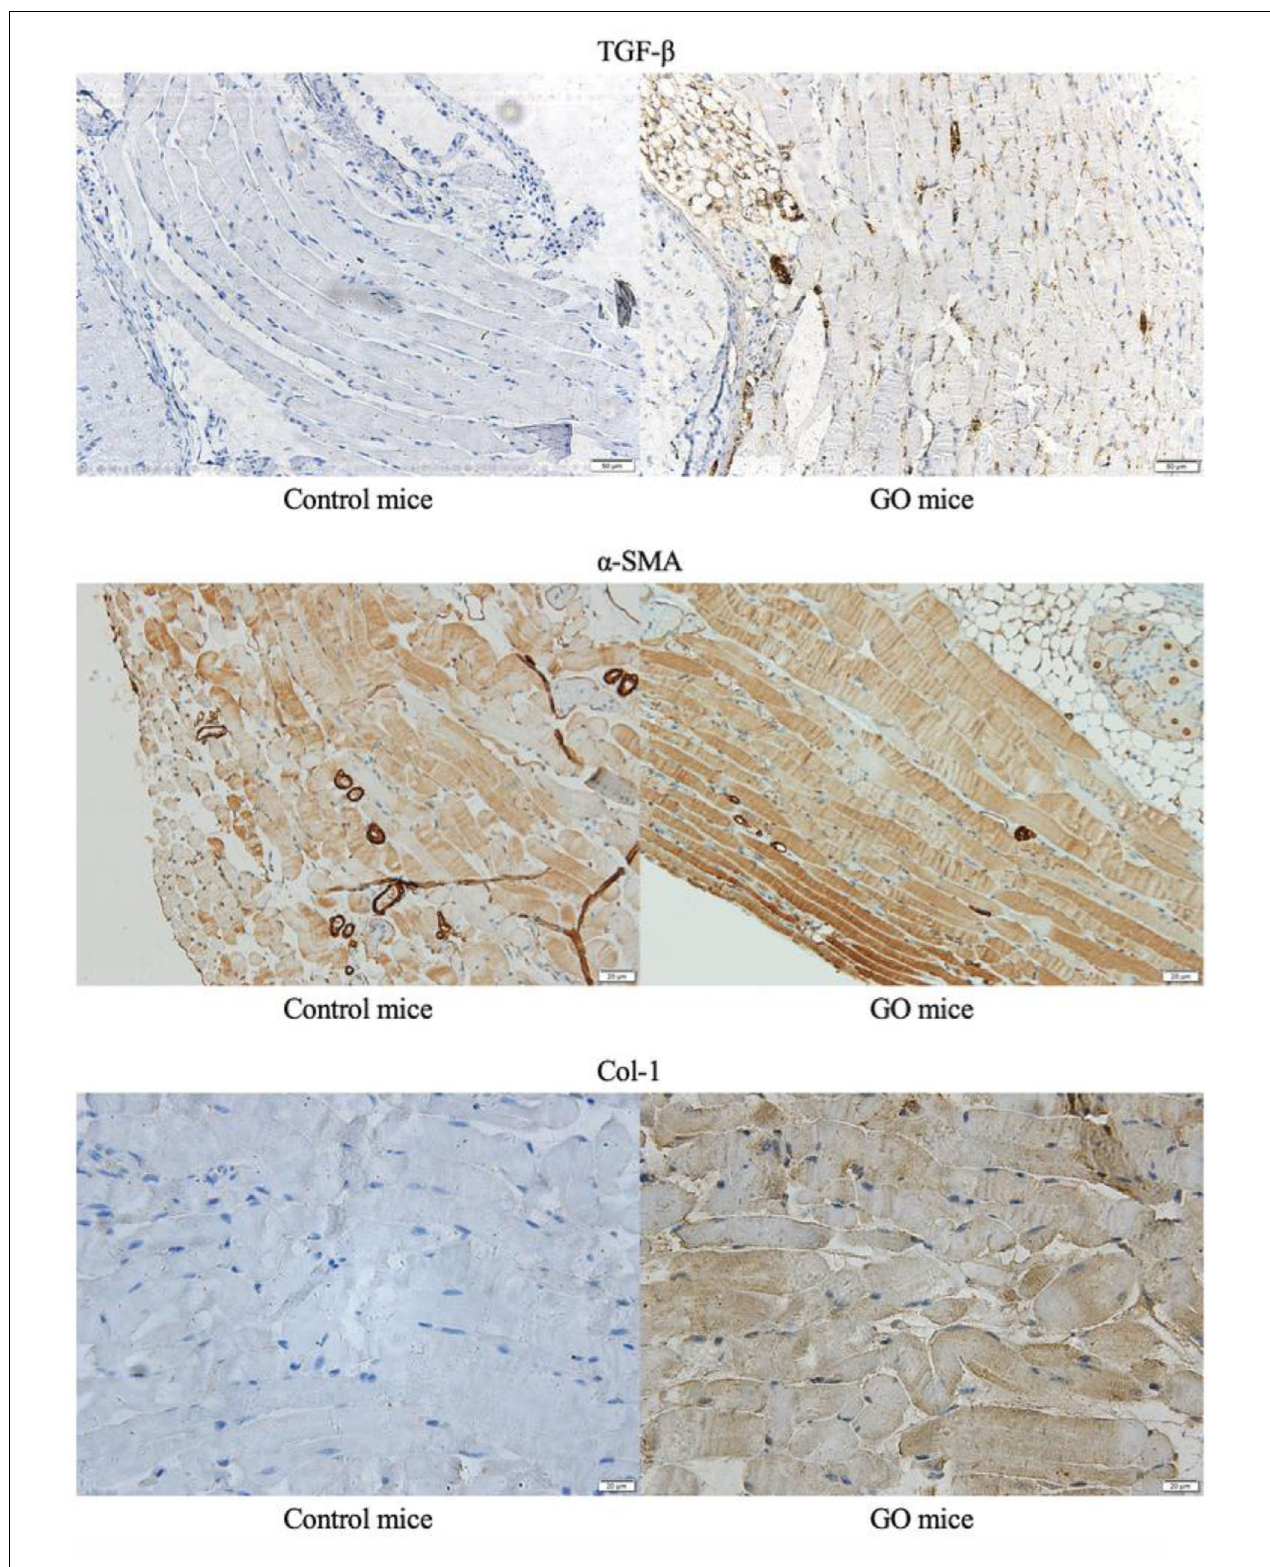
FIGURE 3 | Immunohistochemical staining. The immunohistochemical staining of extraocular muscles in GO mice and control mice.